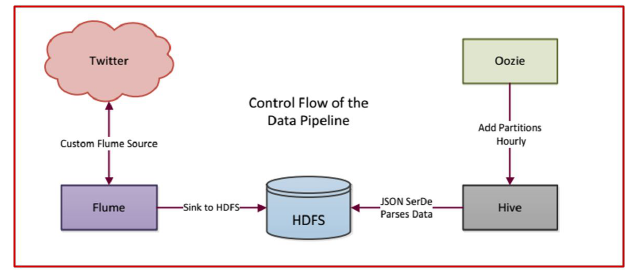
Figure 3. Hadoop